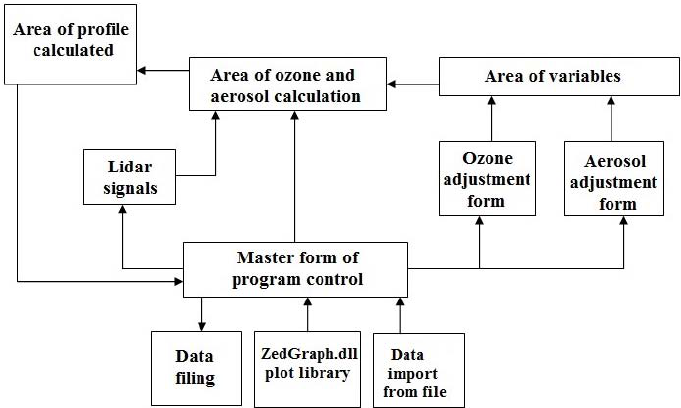
Figure 1. Structure of the software for vertical distribution of ozone (VDO) retrieval from laser sounding